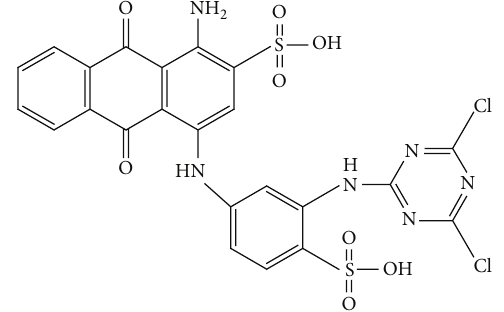
Figure 1: Structure of RB4